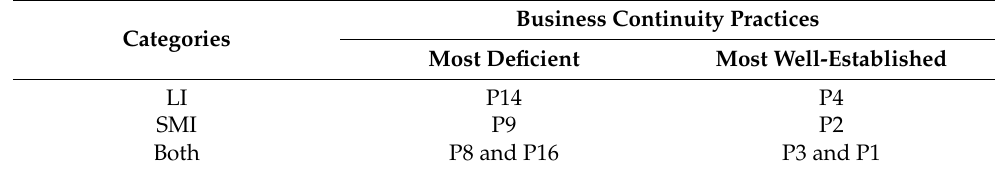
Table 7. Most deficient and well-established practices comparatively defined for LIs and SMIs. Business Continuity Categories